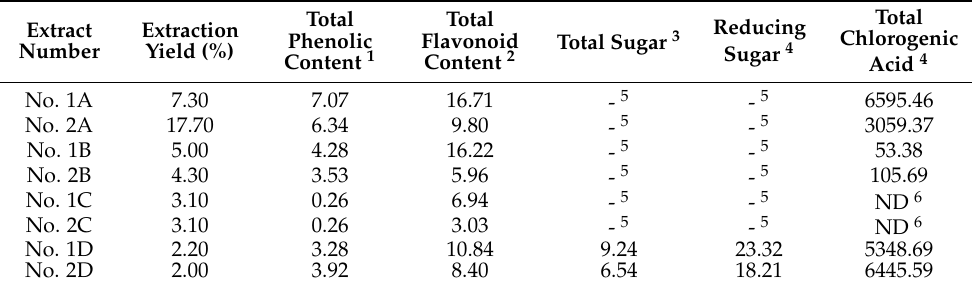
Table 1. Extraction yields (%) and main components of the four solvent extracts of the two varieties of Hang